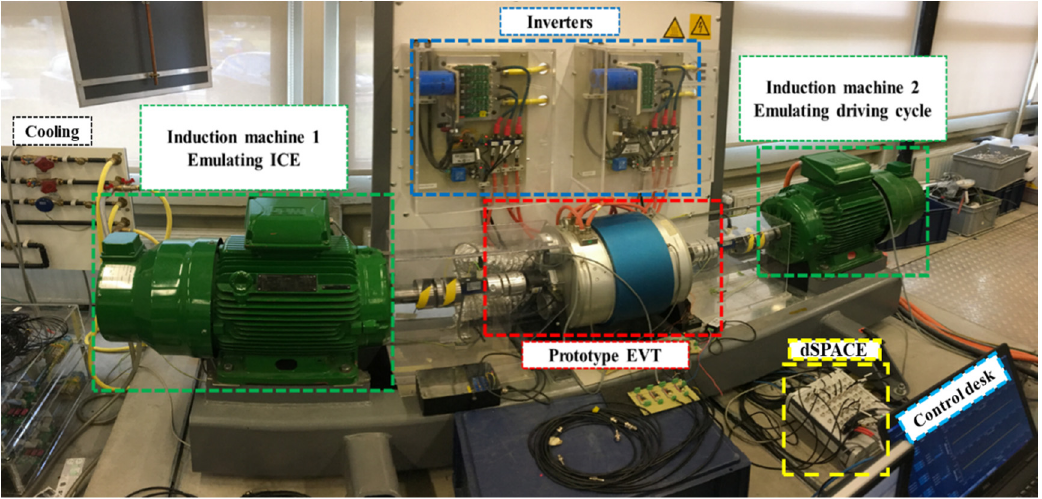
Figure 13. Experimental test bench of the study.